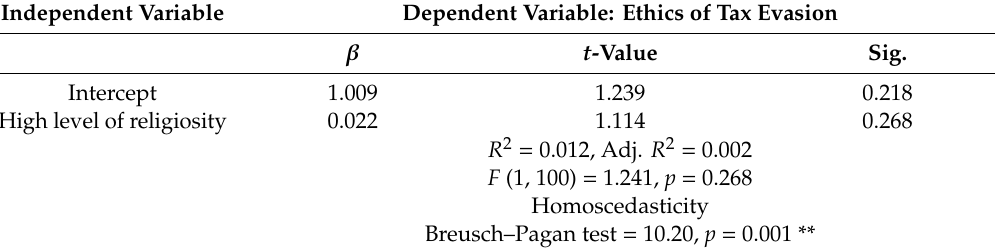
Table 5. Regression Analysis of Model 2.